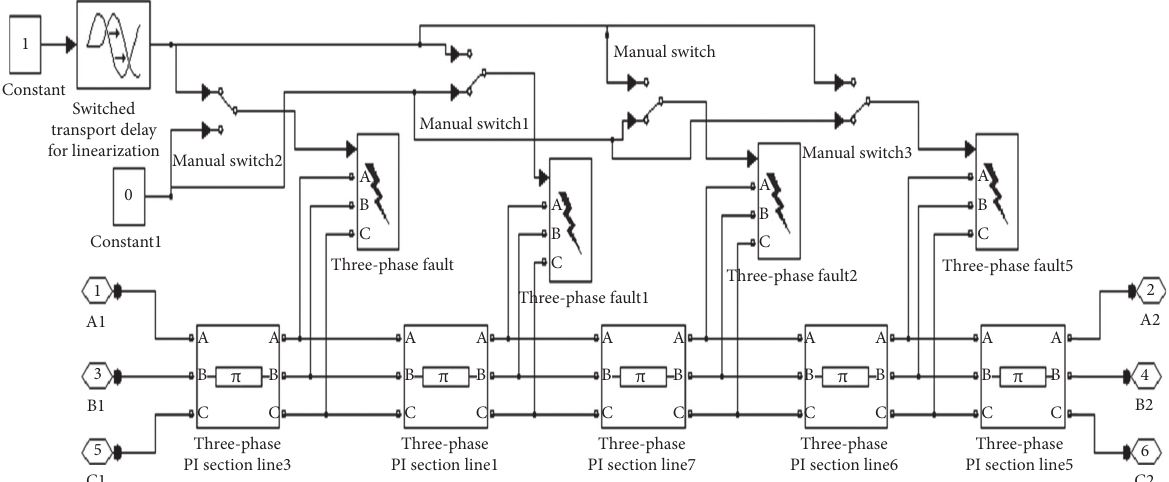
Figure 6: Simulink model for the distribution subsystem of Figure 5 with the faults switched on manually.